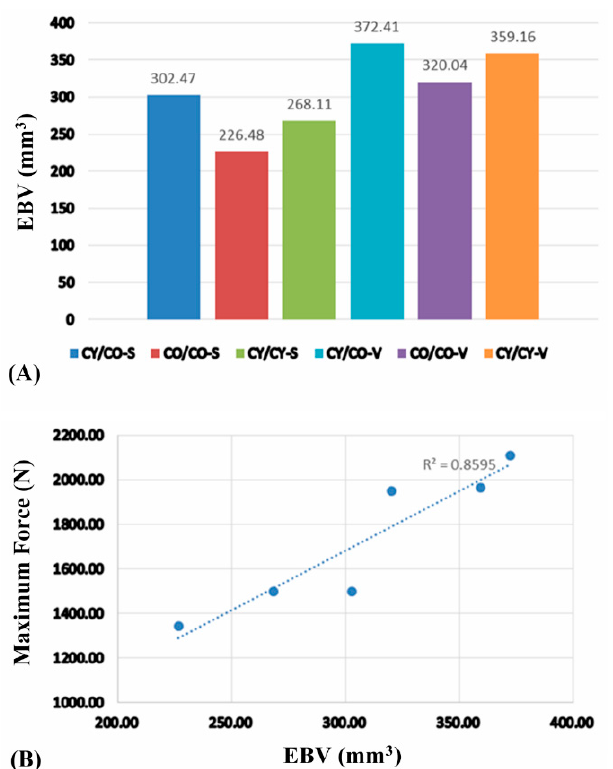
Figure 9. ( A ) The EBV and ( B ) the relationship between the pullout strength and EBV for various screw geometries. A strong positive correlation (R 2 = 0.8595) was noted after comparing the pullout strength of all screws with the EBV .